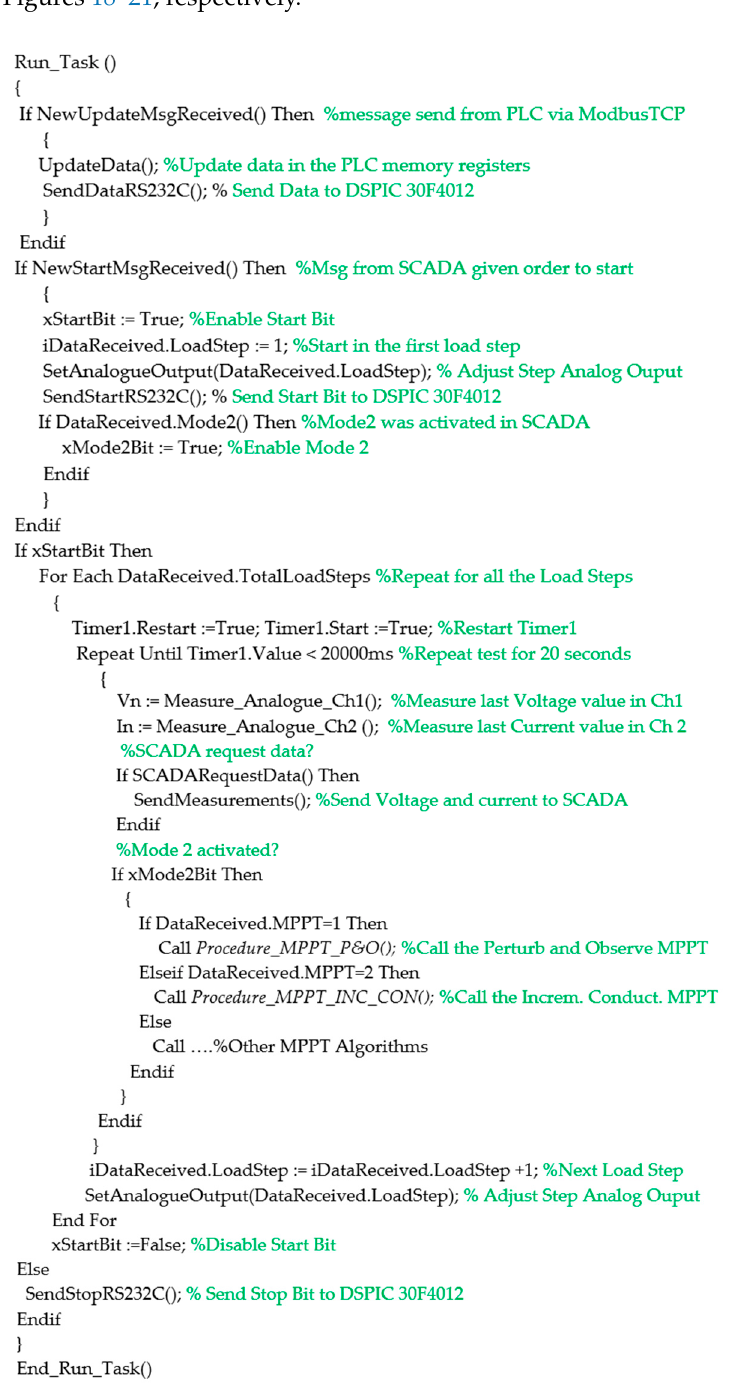
Figure 18. Simplified pseudocode of the main PLC task (developed in Structured Test according to IEC61131-3).